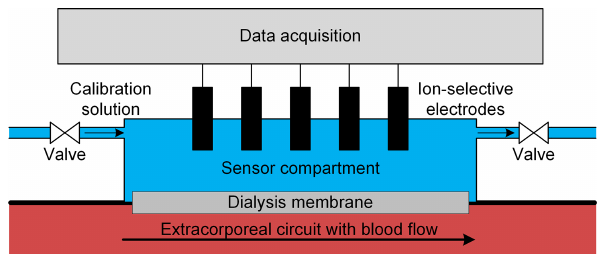
Figure 1. Schematic depiction of the in-line measuring concept with ion-selective electrodes placed in a sensor compartment sepa- rated from the blood in the extracorporeal circuit by a dialysis mem- brane. The sensor compartment also enables calibration of the ion- selective electrodes just before usage by simply flushing the sensor compartment with a calibration solution. Furthermore, cyclical re- calibration is possible for long-term measurements to improve ac-